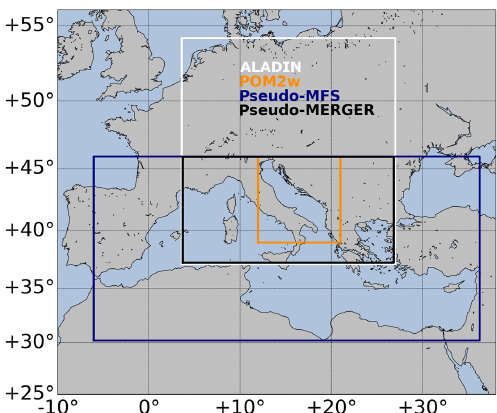
Figure 3. Domains of all OASIS models used in the atmosphere– ocean coupling scheme. White rectangle: atmospheric model AL- ADIN domain. Orange rectangle: ocean circulation model POM2w domain. Black rectangle: remapping pseudo model pseudo- MERGER domain. Blue rectangle: domain defined by the My- Ocean MFS NetCDF files, read by the pseudo-MFS pseudo